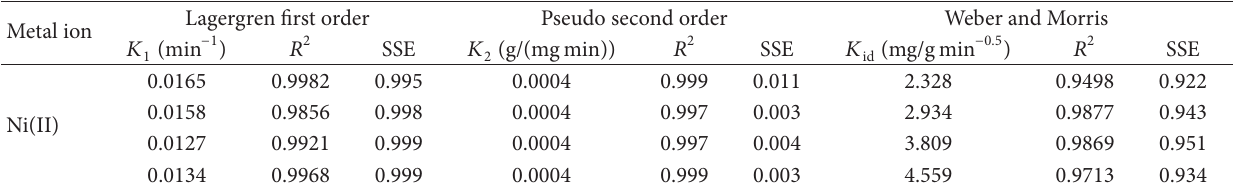
T 1: Kinetic parameters for biosorption of Ni(II) by T. viride biomass.